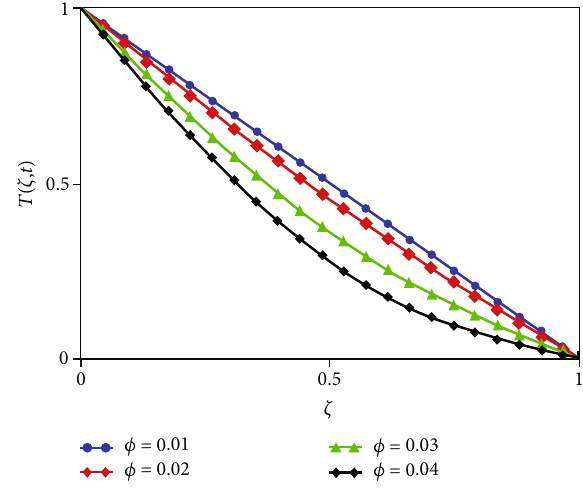
Figure 9: Impact of ϕ on temperature distribution.